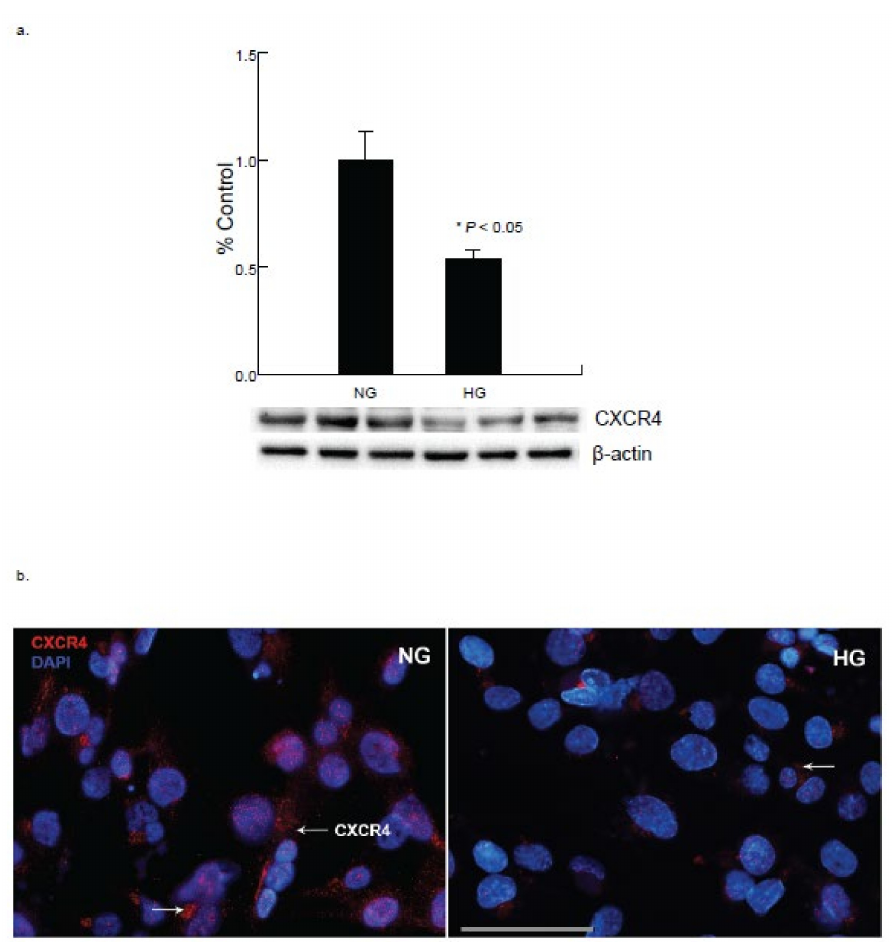
Figure 6. Hyperglycemia alters chemokine receptor CXCR4 expression in cardiomyocytes. ( a ) West- ern blot analysis of cardiomyocytes exposed to hyperglycemic condition for 48 h showed reduction in the expression of CXCR4 (* p < 0.05). ( b ) Immunocytochemical analysis of cardiomyocytes exposed to high glucose (HG) for 48 h showed decrease in the expression of CXCR4 (red). (Scale bar= 100 µ